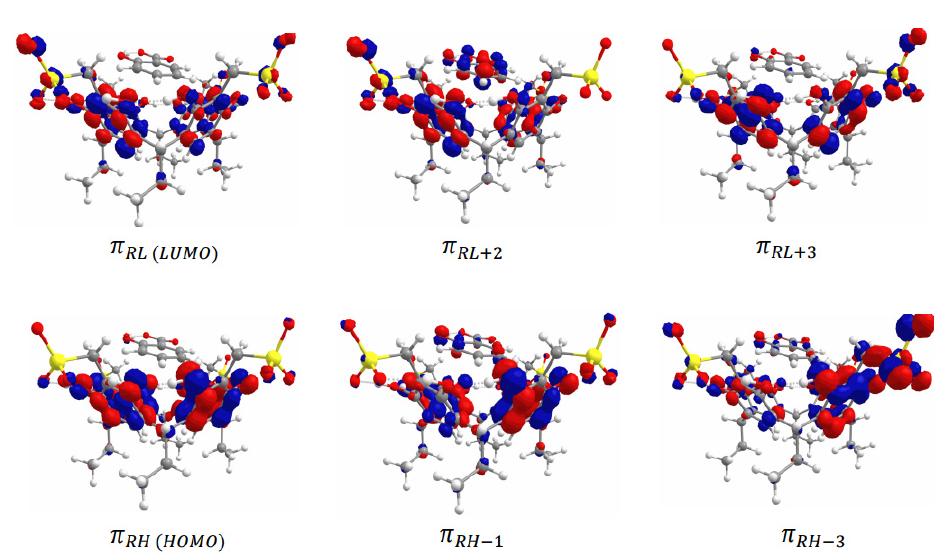
Figure 8. Molecular orbitals of the Na 4 EtRA-NaSal complex. Table 5. Assignment of the bands observed in the absorbance spectra of the host–guest complexes.